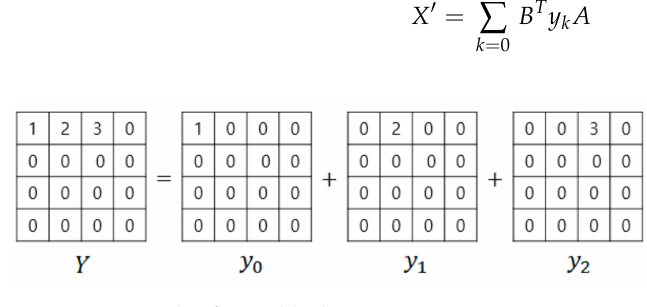
Figure 1. Example of 4 × 4